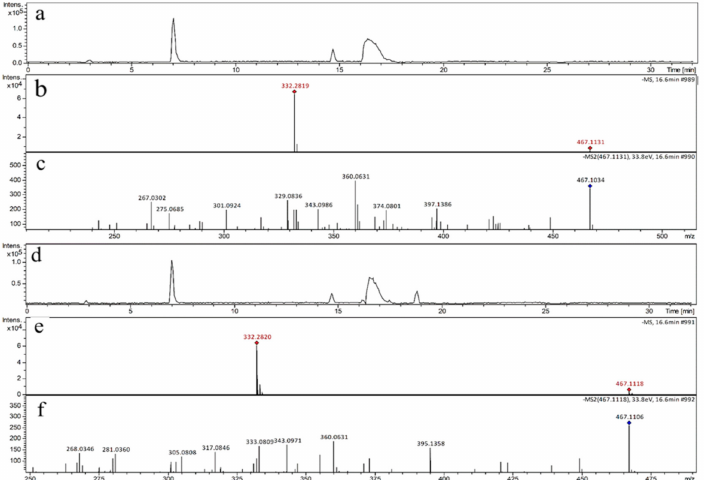
Figure 3. ( a ) The base peak chromatogram of the sample GR ε -VU); ( b ) The mass spectrum of GR ε -VU; ( c ) The MS/MS spectrum of m / z 467.1134 ( m / z 467-1); ( d ) The base peak chromatogram of the sample GR δ -VU; ( e ) The mass spectrum of GR δ -VU; ( f ) The MS/MS spectrum of m / z 467.1118 ( m / z